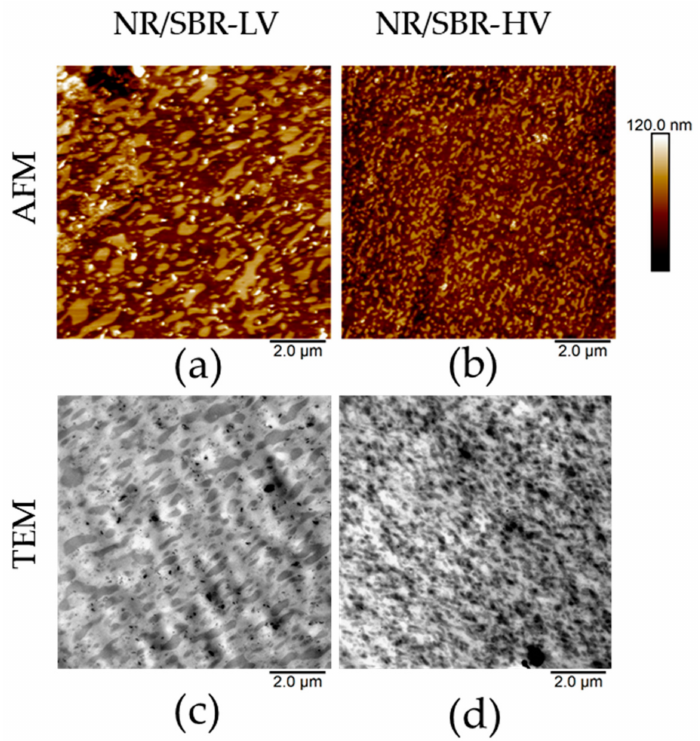
Figure 2. Comparison of atomic force microscopy (AFM) topography maps with TEM images: AFM topography maps of ( a ) NR/SBR–LV and ( b ) NR/SBR–HV and TEM images of ( c ) NR/SBR–LV and ( d ) NR/SBR–HV. The samples were cured at 160 ◦